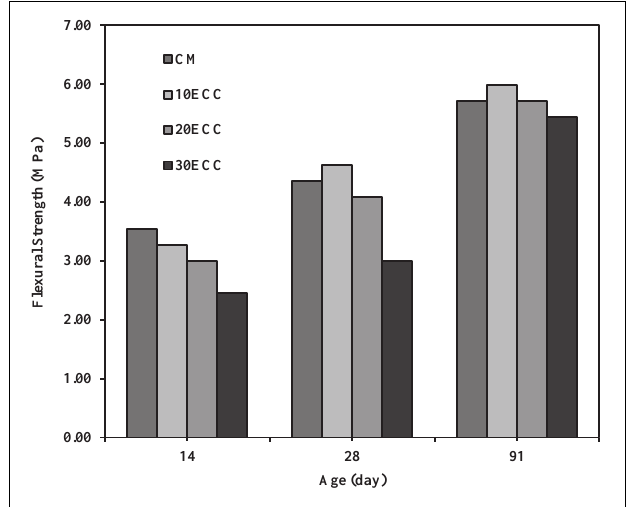
FIGURE 10 | Comparison of flexural strength with aging among CM and the ECC mixes containing different percentages of GBA.